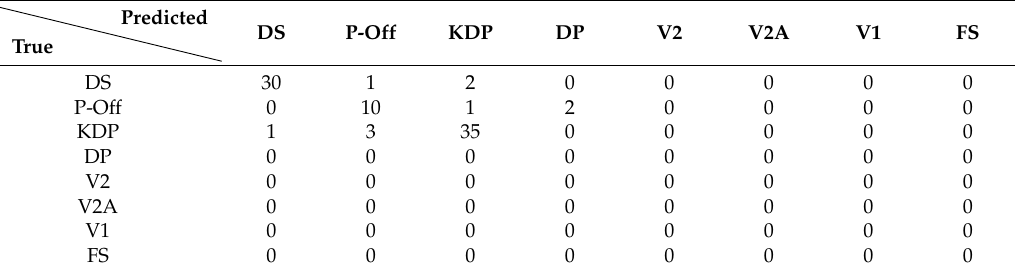
Table A6. Confusion matrix for the flat course, classical style validation set of skier 1 when using the sports biomechanics configuration of sensors.